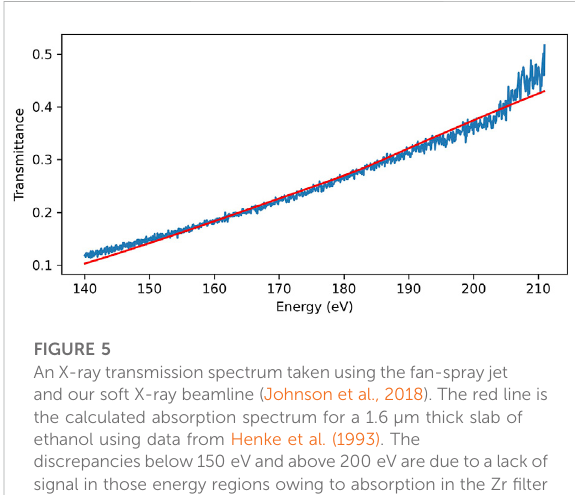
An X-ray transmission spectrum taken using the fan-spray jet and our soft X-ray beamline (Johnson et al., 2018). The red line is the calculated absorption spectrum for a 1.6 µm thick slab of ethanol using data from Henke et al. (1993). The discrepancies below 150 eV and above 200 eV are due to a lack of signal in those energy regions owing to absorption in the Zr fi lter we used to get rid of the driving laser fi